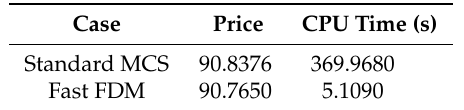
Table 3. Price and computation time of Type 3 ELS prices with the standard MCS and the fast FDM. Case Price CPU Time